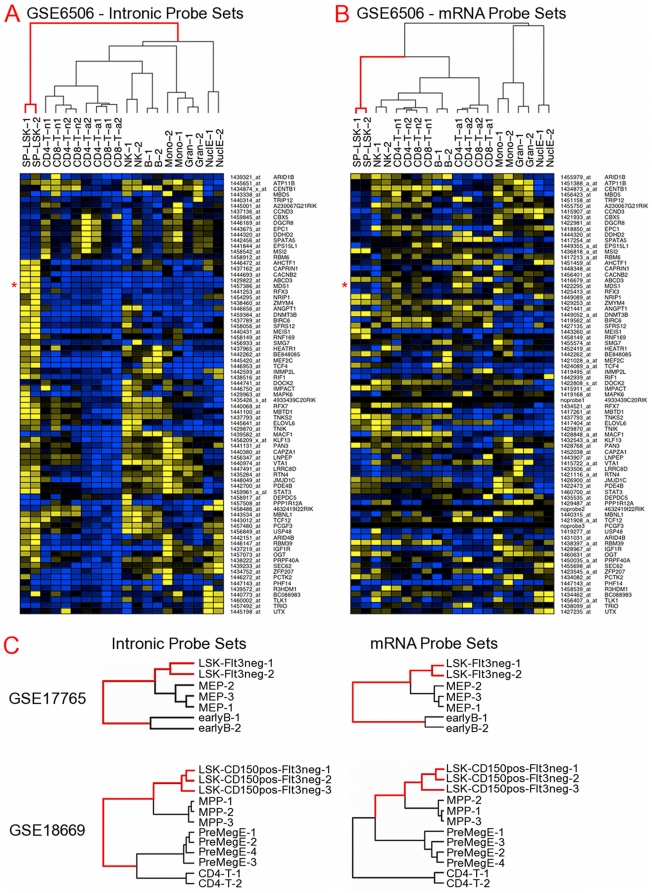
Discriminatory power of intronic probe sets in hierarchical clustering of hematopoietic cell populations.(A) Hierarchical clustering of expression data from Chambers et al
[31] using intronic probe sets down-regulated in Crebbp+/− vs WT HSCs. Cell types represented are adult HSCs (SP-LSK, red branch on the dendrogram), activated (a) and naive (n) CD4+ and CD8+ lymphocytes, natural killer (NK) cells, B cells, nucleated erythrocytes (NuclE), monocytes (Mono), and granulocytes (Gran). (B) Same data set as in (A) but with cell populations clustered using mRNA probe sets for the same target genes. In cases where multiple probe sets were available, the one with the largest difference in Crebbp+/− vs WT HSCs was used. Genes are shown in the same order as in (A) with HSC branches shown in red to the nearest junction point with a mature cell type subtree. (C) Clustering as in (A) (left) and (B) (right) of 2 other published data sets[30], [32] with different subpopulations. As before, red dendrogram branches highlight the distance from HSCs to the nearest mature cell type junction point. LSK: Lin- SCA1+ KIT+; SP: side population; LK: Lin- KIT+; MEP: megakaryocyte/erythrocyte progenitor, LK SCA1- CD34- Fc-gammaRII/III-; MPP: multi-potential progenitor, LSK CD150- FLT3+; PreMegE: megakaryocyte/erythrocyte progenitors, LK SCA1- CD150+ CD105- CD41-.